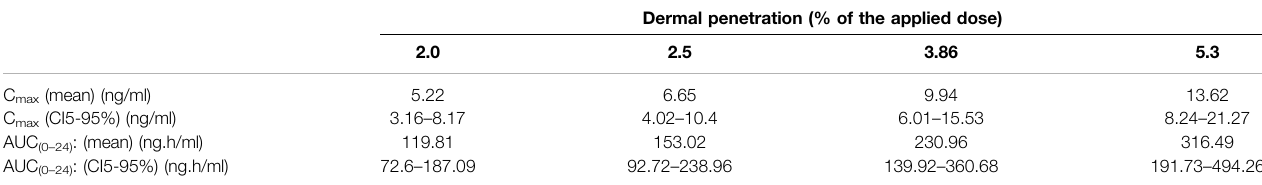
TABLE 5 | Estimated kinetics parameters of homosalate after repeated dermal exposure over 30 days and different dermal penetration potential. For each scenario, 10% homosalate was applied to the whole-body surface (17500 cm 2 ) twice a day (18 g cream per day, 103 μ g/ cm 2 / day). The same set of the in fl uencing homosalate- speci fi c input parameters and the population modeling were implemented to calculate the C max uncertainty. The values for the Day 30 kinetics. Dermal penetration (% of the applied